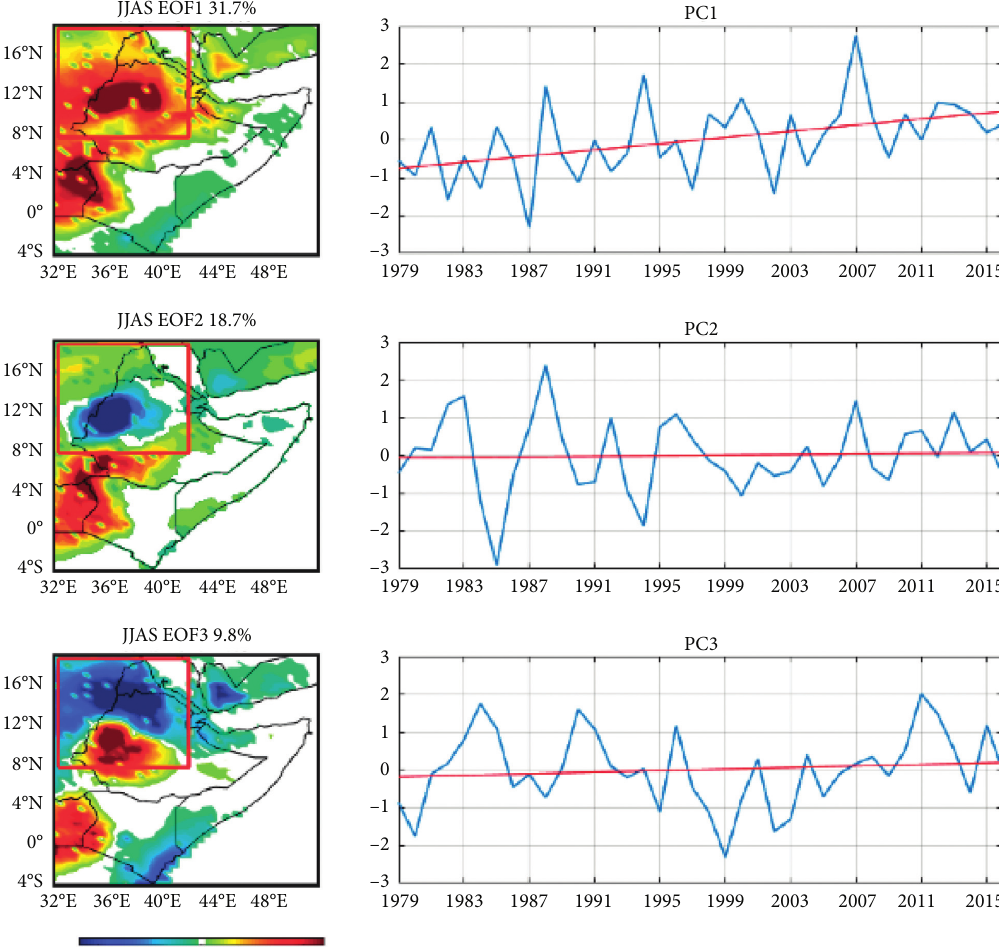
Figure 5: Spatial patterns of the first three EOF modes of summer rainfall over the GHA (left panels) and the corresponding principal components: PC1, PC2, and PC3 (right panels), respectively. Red box in left panels is the JJAS